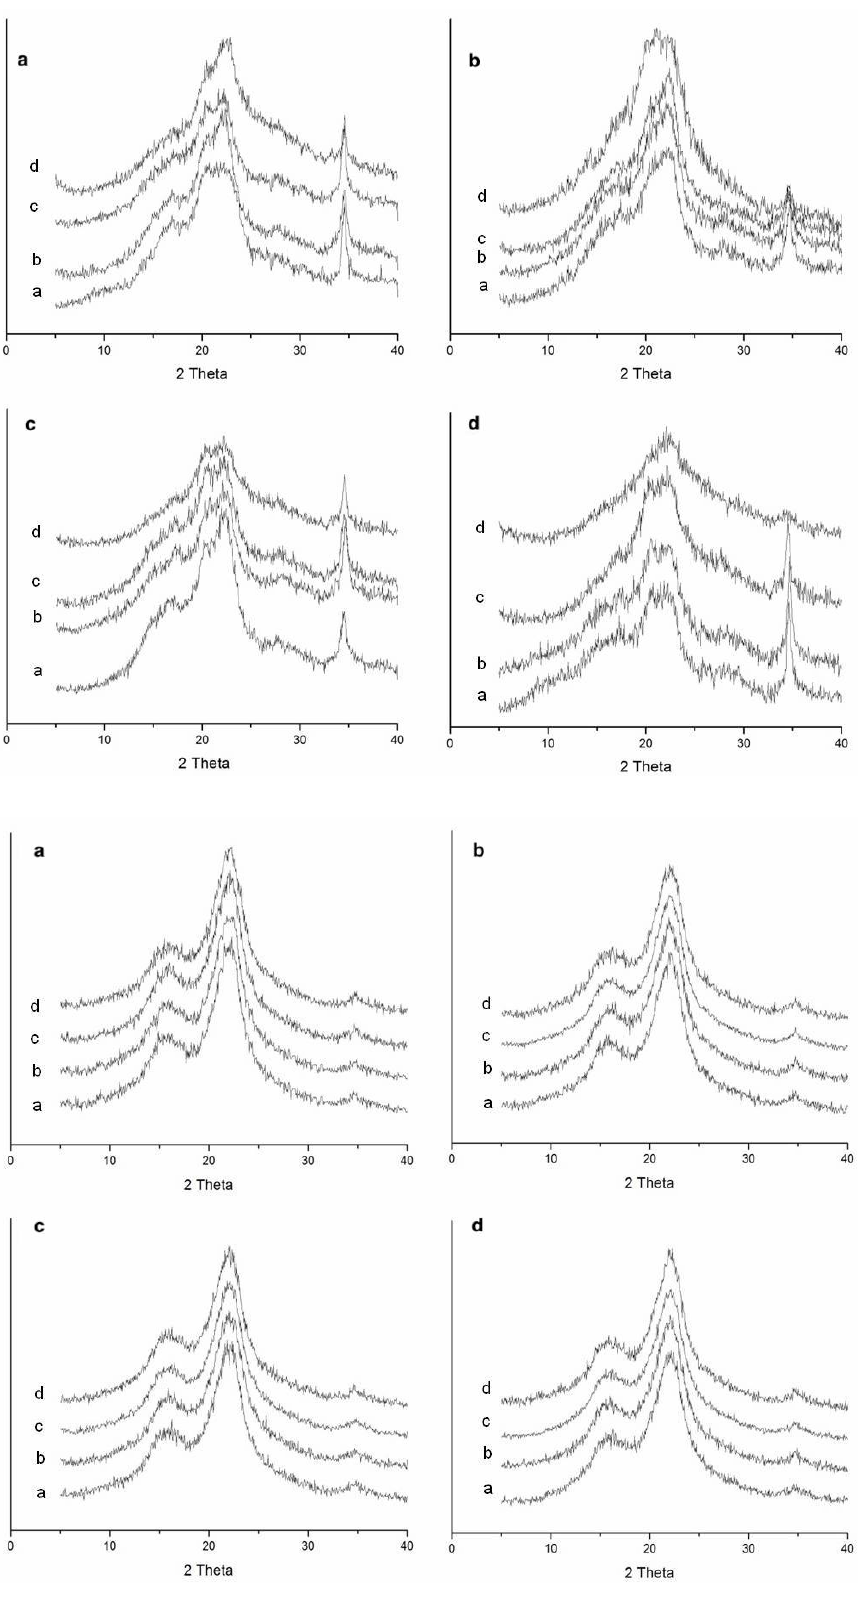
Figure 7. X-ray diffraction analysis of soybean hull treated with [bmim][Ac] (a and c), and [bmim][Cl] (b and d), for 2 h (a and b), and 6 h (c and d). Legend: a) untreated biomass, b) IL 50 % and 75 °C, c) IL 100 % and 75 °C, and d) IL 100 % and 100